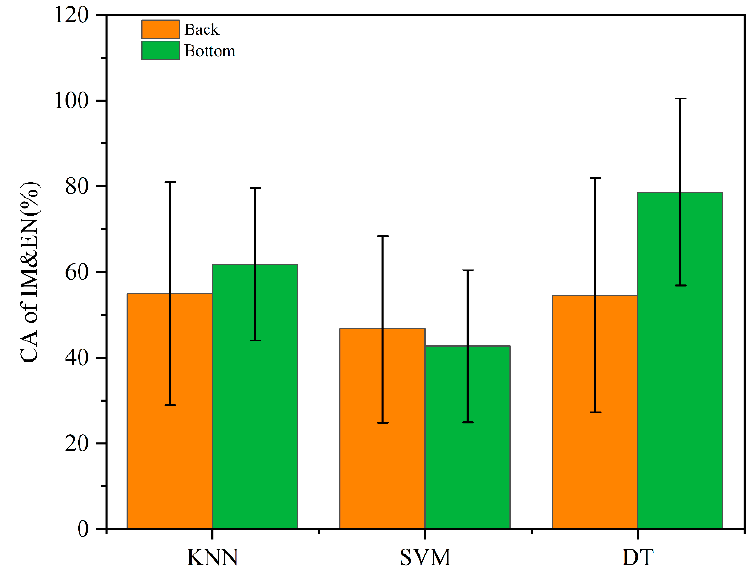
Figure 5. CA of IMEN walnuts.